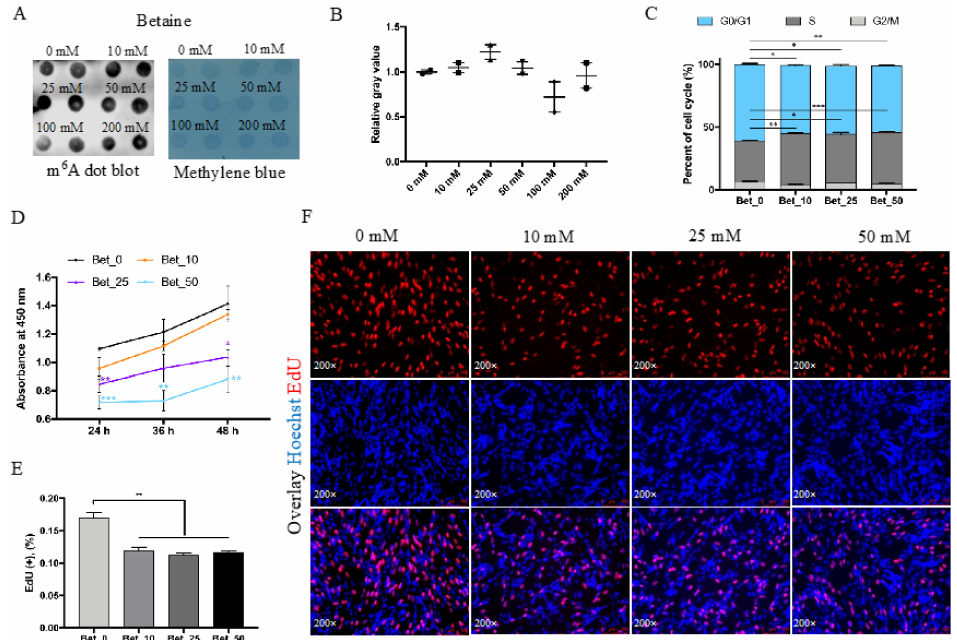
Figure 1. Betaine inhibits myoblast cells proliferation. ( A ) RNA dot blot and methylene blue results after being treated with 0, 10, 25, 50 mmol/L betaine for 24 h. ( B ) The relative gray value of RNA dot blot. ( C ) Cell cycle analysis of different cell stages after 24 h betaine treatment. ( D ) The statistical results of CCK-8 assay after 24 h, 36 h, and 48 h betaine treatment. ( E ) The EdU positive cell rate ( F ) and EdU staining of myoblast cells being treated with betaine. (mM refers to mmol/L; * p < 0.05; ** p < 0.01; *** p <